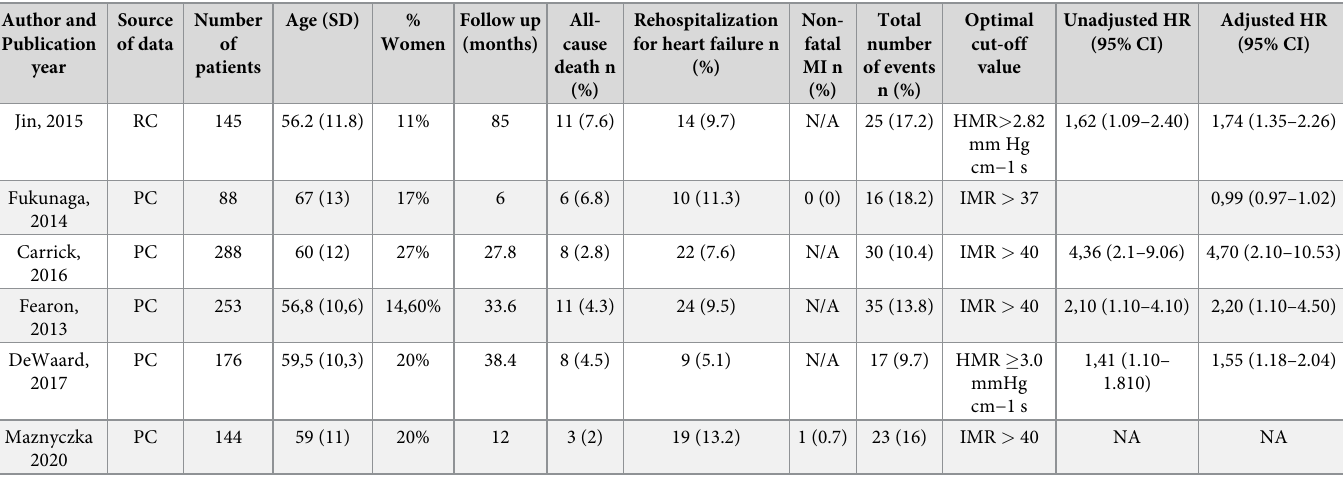
Table 1. General characteristics of included